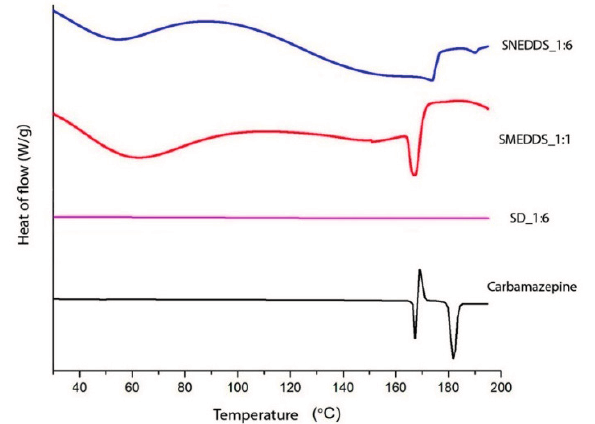
Figure 3. DSC curves of evaluated formulations and pure